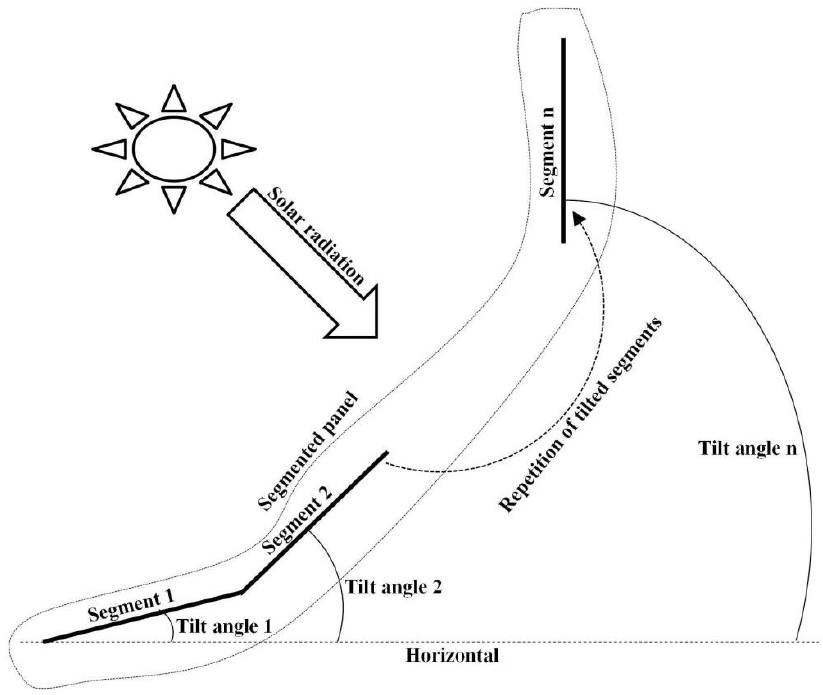
Figure 2. Poly-tilted segmented panel.